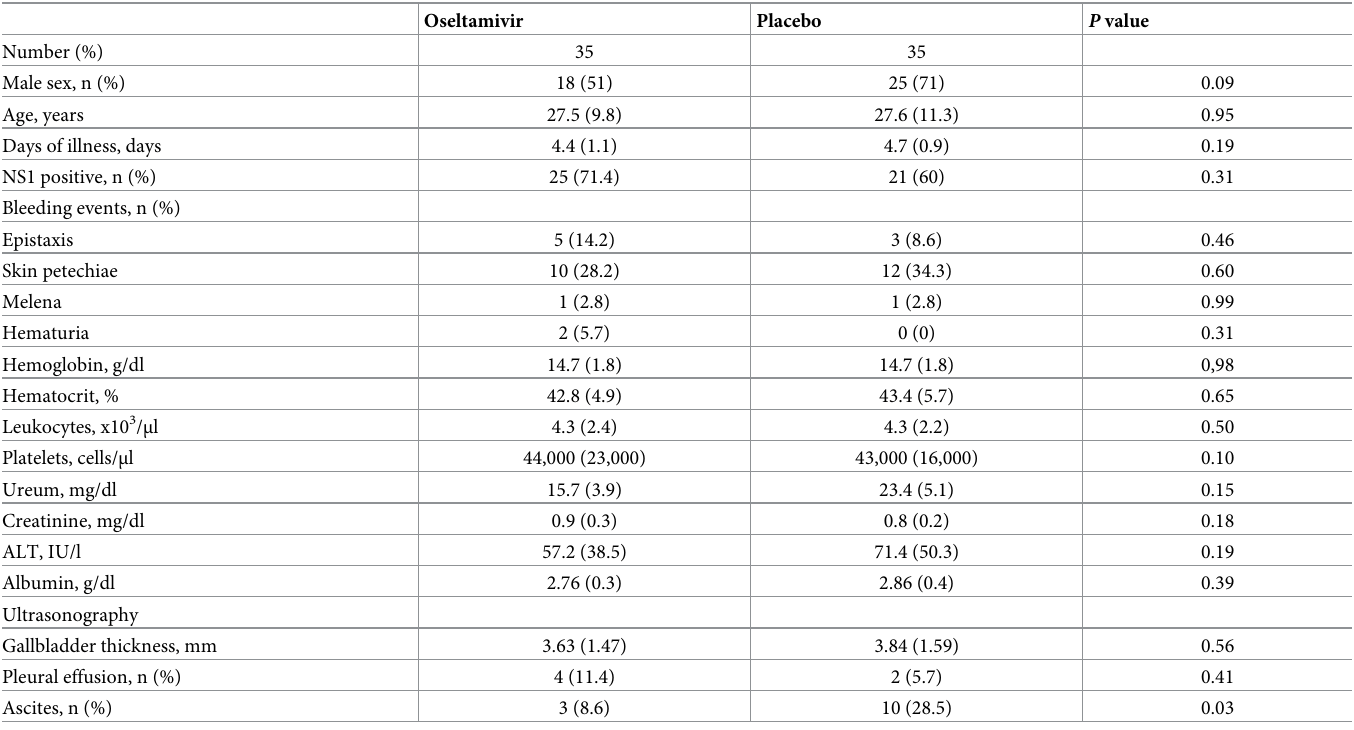
Table 1. Characteristics of study participants.